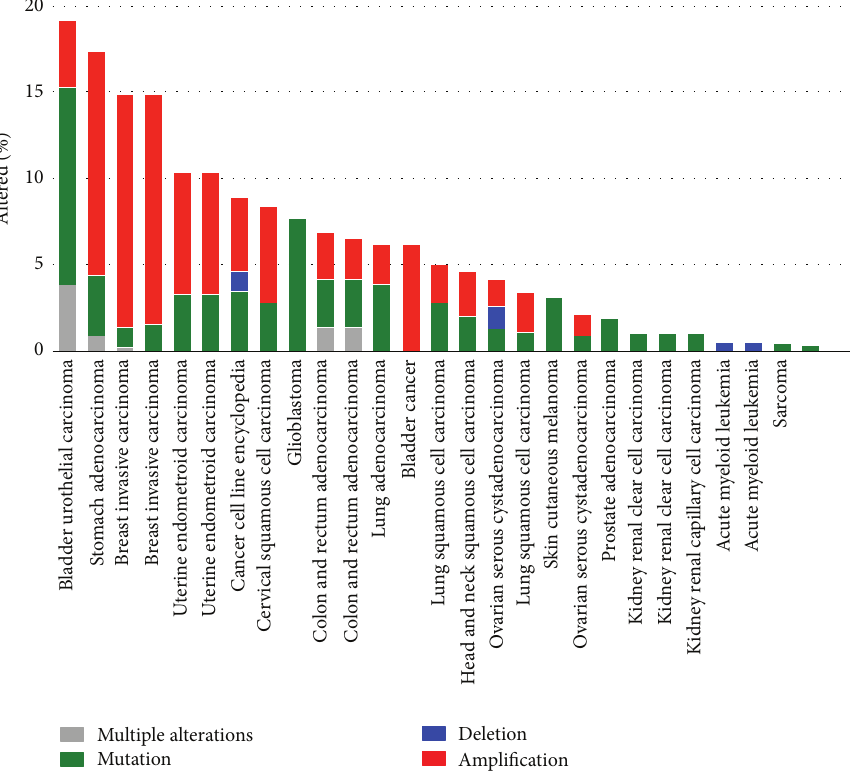
Figure 3: Patterns of HER-2 in different cancers. Bar chart shows genetic changes in a wide range of different tumours and cancer types, including mutation, deletion, and amplification. Note that amplification is particularly prevalent in invasive carcinoma of the breast. Data was generated using the cBIO Cancer Genomics Portal [14, 15].